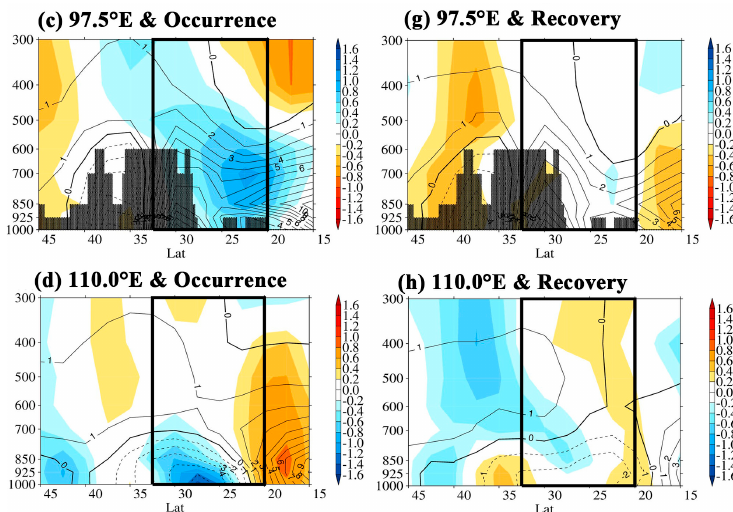
Figure 9. Vertical cross-sections of composite meridional or zonal water vapor transport (WVT) for wetter: ( a – d ) occurrence; and ( e – h ) recovery at boundaries of Southwest China (SWC). Contours represent WVT, for which the unit is 10 -1 kg m -1 s -1 hPa -1 . Standardized anomalies (SA) are shown by shadows, whereas warm and cold colors indicate inflow and outflow, respectively. The bold black box indicates the area over SWC. The black shadow areas in ( b , c , f , g ) represent the Qinghai–Tibet Plateau.